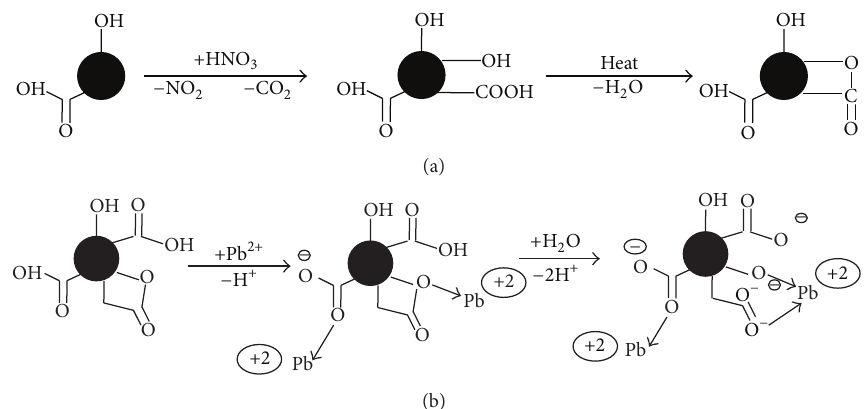
Figure 11: Proposed mechanism involved in the adsorption process: (a) oxidation by HNO 3 and (b) binding mechanism of lead ion.